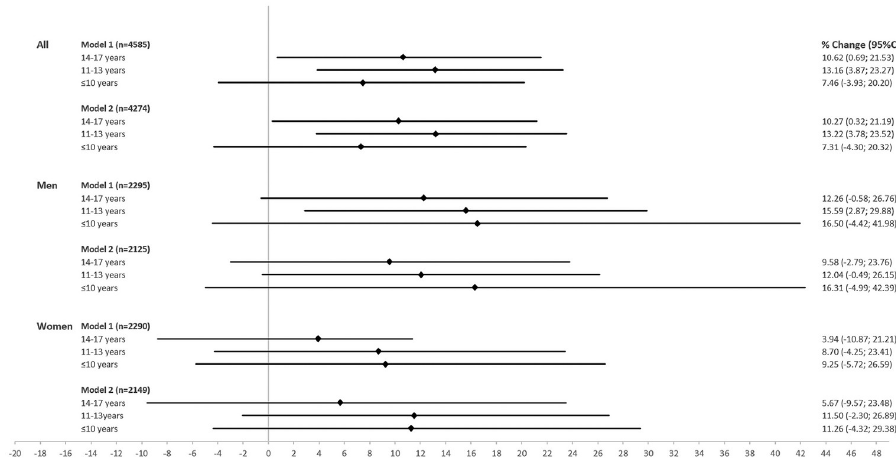
Fig 3. Effect size estimates as percentage change in NT-proBNP and 95% confidence intervals (95%-CI) using education categories ( � 18 years of education as reference) in the main analysis population and stratified by